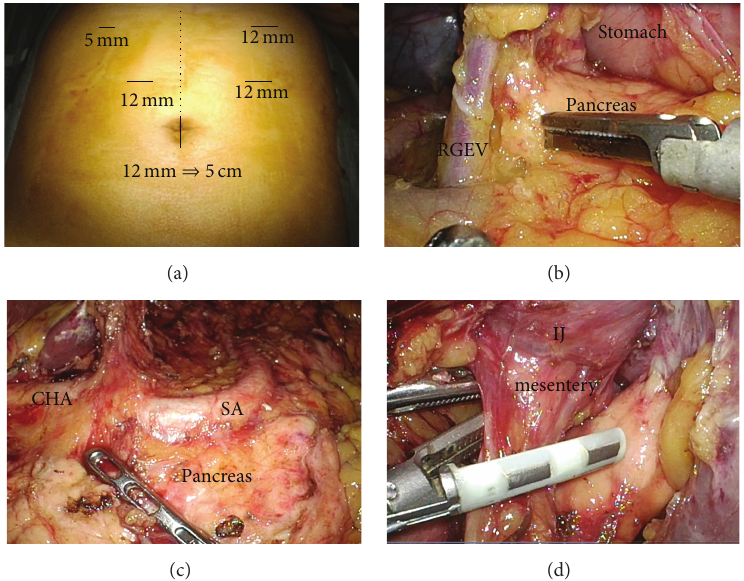
Figure 1: Port sites and lymphadenectomy at laparoscopic remnant total gastrectomy. (a) The port sites and scar of initial gastrectomy (dotes line). (b) Station number 6 lymph nodes were completely removed (RGEV; right gastroepiploic vein). (c) The suprapancreatic lymph nodes (station numbers 8a, 9, and 11p) were dissected en bloc (CHA; common hepatic artery, SA; splenic artery). (d) The mesentery of the interposed jejunum (IJ) was transected using a vessel sealing system (LigaSure (cid:2) Blunt Tip 5 mm–37 mm, Covidien, Tokyo, Japan).